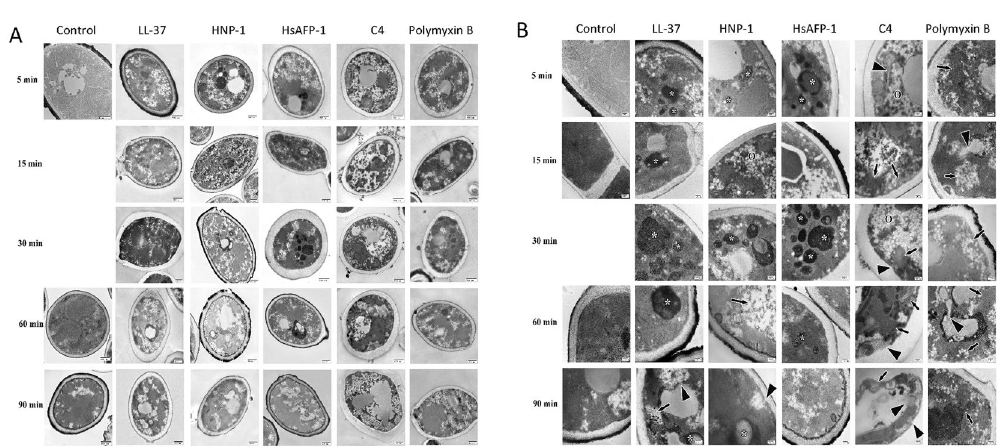
Figure 4. Transmission electron micrographs of C. albicans SC5314 treated with control or 10 × the MIC of antimicrobials. C. albicans were treated with either PBS, C4, or the antimicrobial peptides LL-37, human neutrophil peptide (HNP)-1, Heuchera sanguinea antifungal peptide (HsAFP)-1 or polymyxin B. At the indicated times the yeast (3.4 × 10 6 cfu/ml) were quickly washed, fixed and processed for embedding. Contrast was generated during post-fixing with osmium tetroxide, en bloc staining with uranyl acetate, and section staining with lead citrate. Samples were viewed at 80 kV on a Hitachi 7600. ( A ) Images were captured at a magnification of 30,000 × to gain an overview of cellular changes. ( B ) Images were recorded at 100,000 × magnification to see internal structural changes in the cells. The stars ( * ) indicate autophagy-related structures (condensed, yet fragmented nuclear fractions), large arrowheads denote clearly visible membrane ruptures and membrane internalizations (lollipops), smaller arrows are used to indicate damage to internal cell architecture, and the large ‘O’ shows internal aggregates of lipid